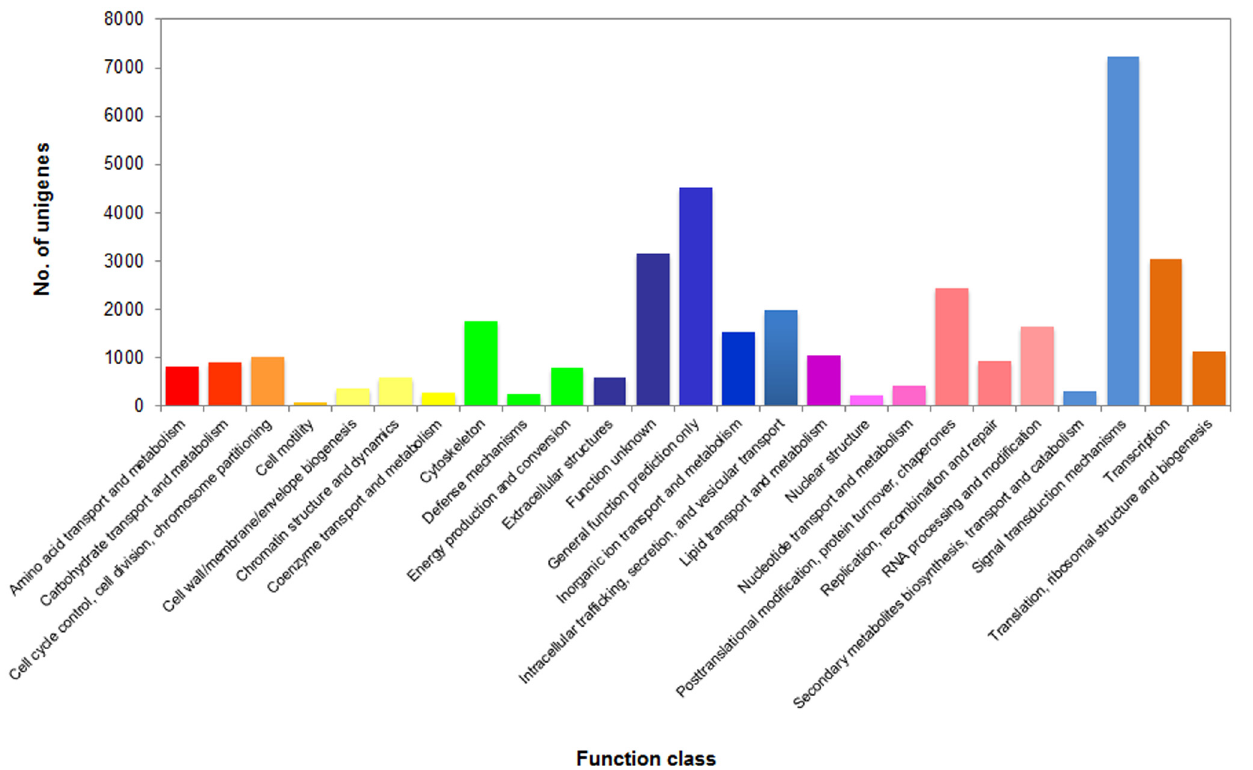
Fig 3. COG classification of putative proteins for S . maximus transcriptome.